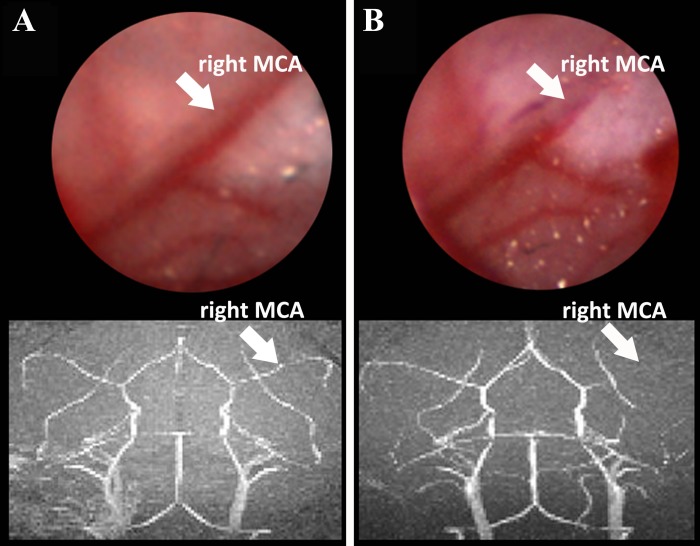
Representative response of proximal MCA to rose bengal-mediated photothrombotic occlusion.A) View of proximal MCA before occlusion under a stereoscopic microscope (upper panel) and on MRA (lower panel). B) View of occluded proximal MCA (white arrows) under a stereoscopic microscope (upper panel) and on MRA (lower panel).